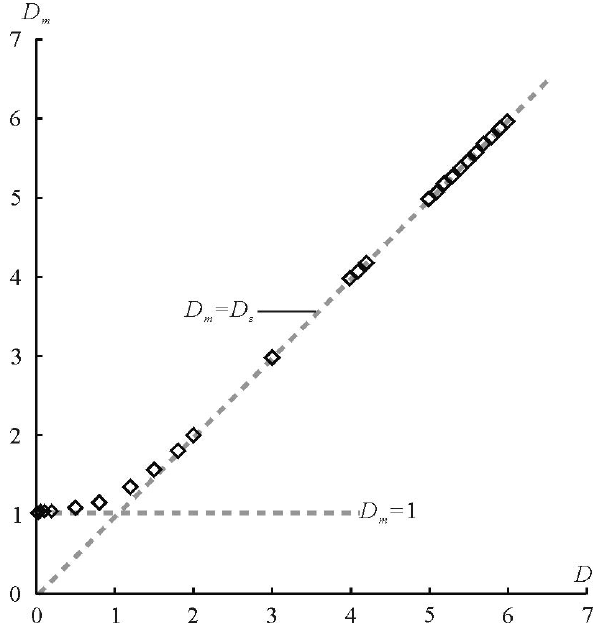
Fig. 3. Plots of fractal dimension D s of the number-size model and the corresponding fractal dimension D m of the number-average size model, obtained according to the Eqs. (10), (15) and (17), as r c varying from 1 to 20 and D s ranging from 0.01 to 6 with r min = 1 and r max =